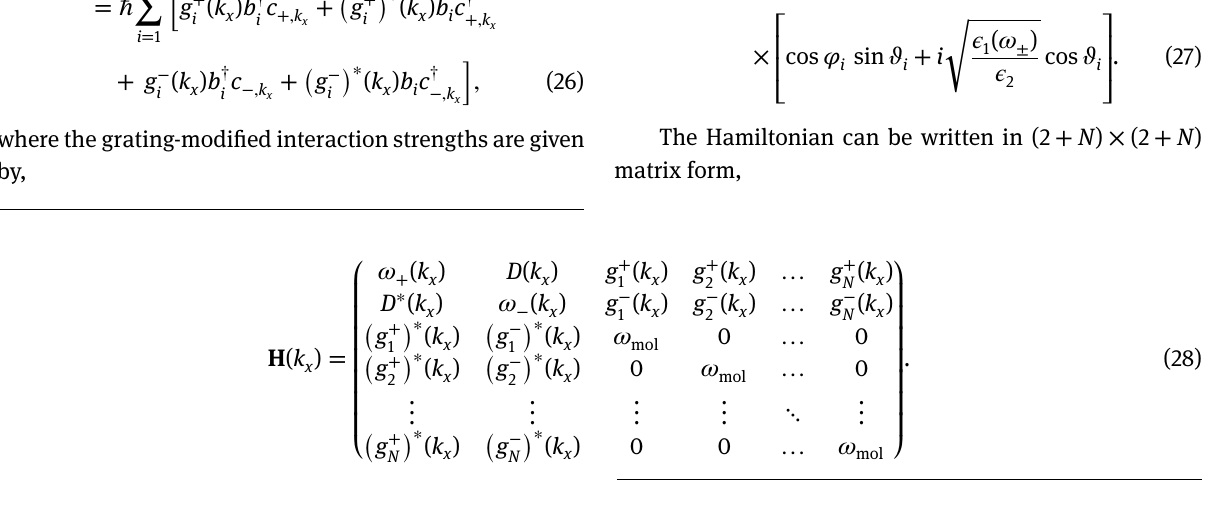
ofthelowerpolaritonwiththemolecularresonance.Figure 3(c(v–vii)) show intermediate systems when two of the couplings are turned on together. When the molecules are coupled to only one polariton branch we see four bands, but when both polaritons are coupled ( g + , g − ≠ 0) we see five distinguishable bands, as in Figure 3(c(v)). These are comprised of four bright bands and N − 2 dark molecular bands. Figure 3(c(viii)) shows the final dispersion relation for D , g + , g − ≠ 0, which is very similar to Figure 3(c(v)), with the inclusion of the slightly splitting and mixing of the two plasmon bands at their point of intersection. This model agrees with experimental results [16]. To see the five-band dispersion relation, the molec- ular distribution and SPs must extend across the full grating profile. The spatial position of each molecule can = a Λ + b = 0 , 1 , 2 … , 0 ≤ b be defined as x S , where a i i i i i ≤ 1, and 0 ≤ S ≤ Λ . S parameterises how molecules are localised in each grating period. For S = Λ the molecules are found everywhere, while for S → 0 the molecules are concentrated in a small fraction of each grating period (Figure 4(a)). In Figure 4, we show that if the molecules